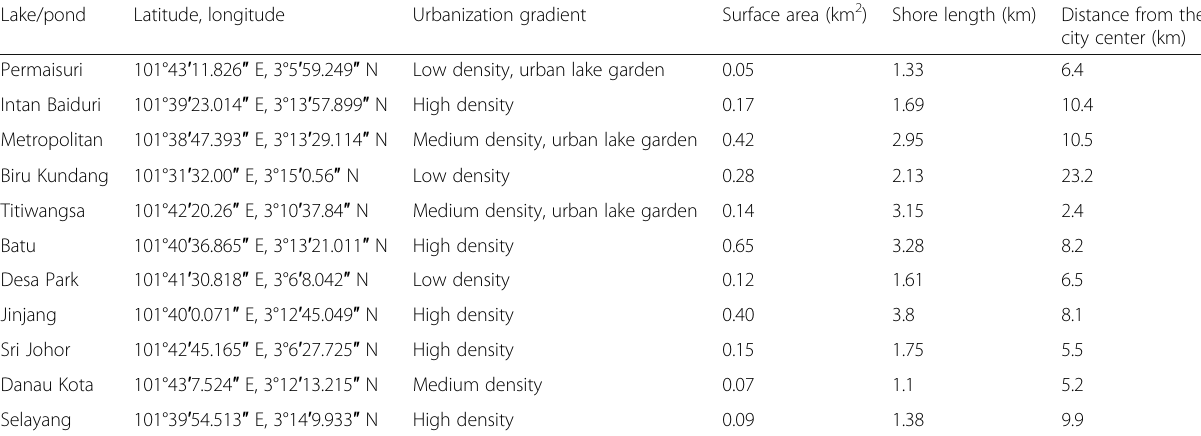
Table 1 Physical characteristics of studied lakes and ponds Lake/pond Latitude, longitude Urbanization